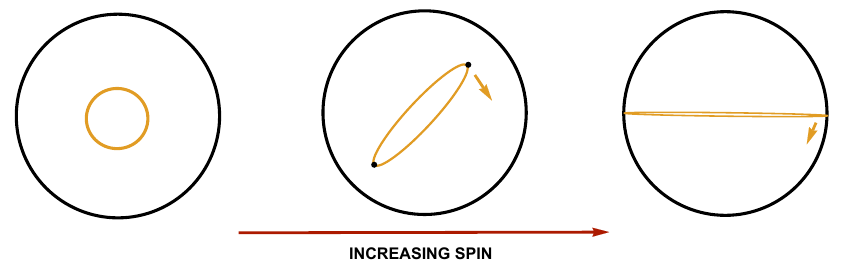
Figure 3 . Illustration of a spinning folded string in the AdS cylinder. At the small spin limit the string is circular and stays near the center, as spin is increased folds start to appear at marked points on the worldsheet, and finally the folding points touch the